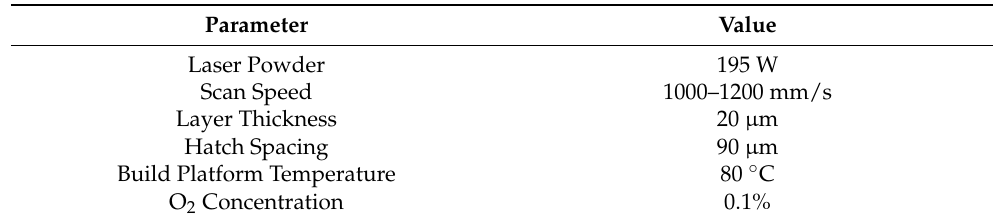
Figure 4. Manufactured test samples ( a ) Density cube for micro-sectional analysis of as-built parts and ( b ) Overhang structure to determine the surface roughness of. Table 2. EOS Processing parameters for 316L Stainless Steel.